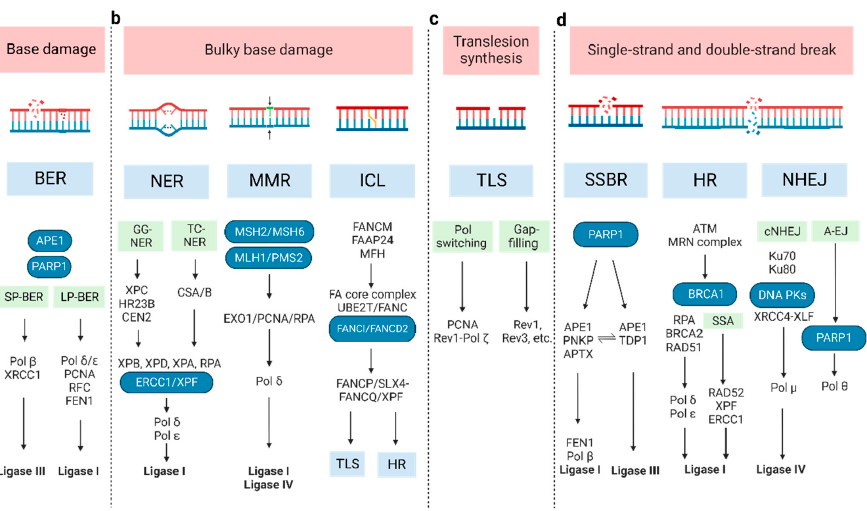
Figure 1. The molecular pathways of DNA damage repair. ( a ) BER can remove a single damaged base and is divided into two sub-pathways: short-patch (SP-BER) and long-patch (LP-BER). ( b ) For bulky base damage, NER removes the damaged base and several adjacent nucleotides, through global genome NER (GG-NER) and transcription-coupled NER (TC-NER); MMR corrects mis-in- corporated bases and strand crosslinks; ICL repair, also known as FA pathway, resolves the cova- lently linked DNA strands. ( c ) TLS repair uses specialized DNA Pols to bypass DNA damage or fill single-strand DNA gaps by inserting and/or extending nucleotides, via Pol switching model and the gap-filling model. ( d ) SSBR repair shares most enzymatic steps with BER pathway; the main repair processes for DSB are HR, SSA, cNHEJ, and A-EJ. (A-EJ: alternative end joining; BER: base excision repair; cNHEJ: classic non-homologous end joining; DSB: double-strand break; HR: homol- ogous recombination; ICL: inter-strand crosslink; MMR: the Mismatch Repair; NER: nucleotide ex- cision repair; NHEJ: non-homologous end joining; SSBR: single-strand break repair; TLS: Trans le- sion synthesis). 2.1. Base Damage Repair Base excision repair (BER): Base damage occurs when chemical bonds within the DNA molecule are formed abnormally. BER can remove a single damaged base. At the beginning of BER, a series of lesion-specific DNA glycosylases remove the damaged base by cleaving the N-glycosidic bond linking the base to its corresponding deoxyribose [22]. Apurinic/apyrimidinic endonuclease 1 (APE1) and poly ADP-ribose polymerase 1 (PARP1) can sense and bind to the damage site. This catalyzes poly ADP-ribosylation (PAR) and some other protein substrates, which allows for the recruitment of repair pro- teins. The next synthesis/ligation step of BER is divided into two sub-pathways—short- patch and long-patch [23]. In short-patch BER, the polymerase beta (Pol β ) fills the gener- ated gap with the correct nucleotide [24]. The successive ligation of the DNA ends de- mands either DNA ligase I (LIG1) or the complex of DNA ligase III (LIG3) and X-ray re- pair cross-complementing protein 1 (XRCC1). In long-patch BER, proliferating cell nuclear antigen (PCNA), replication factor-C (RFC), flap endonuclease-1 (FEN1), Pol δ / ε , and LIG1 are included [24]. 2.2. Bulky Base Damage Repair Nucleotide excision repair (NER): This pathway removes bulky lesions, which in- volves removing the damaged base and several adjacent nucleotides [25]. The significant lesions initiating NER are pyrimidine dimers, such as cyclobutene pyrimidine dimers (CPD), and 6–4 photo-products induced by ultraviolet light- cisplatin-DNA intra-strand